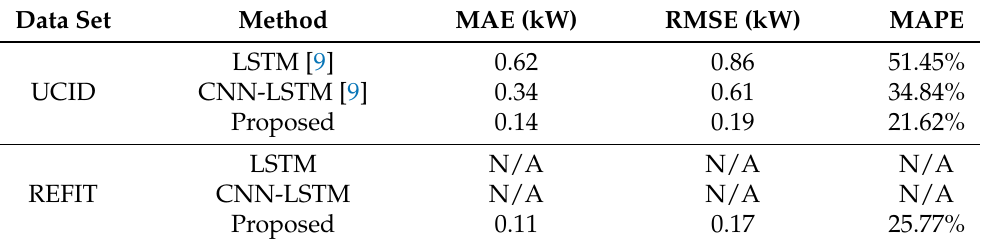
Table 4. Performance comparison of different methods used for the UCID and REFIT datasets. Note that these results were obtained for one-step-ahead predictions at a resolution of 15 min from the raw datasets.